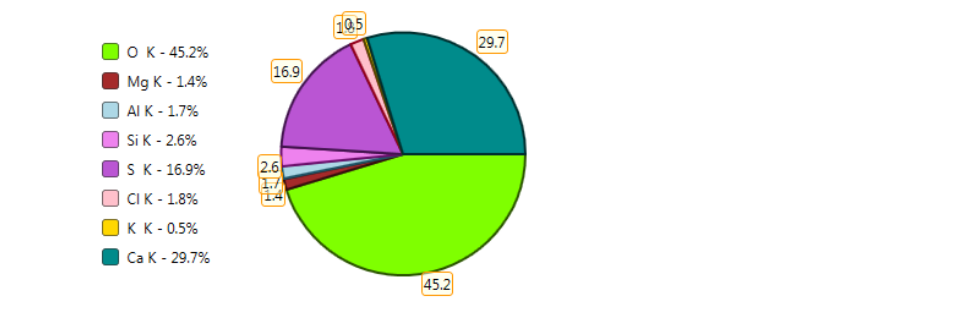
Figure 20. X-ray microanalysis (EDS) in point 1, percentage by mass of ingredients of the mineral.